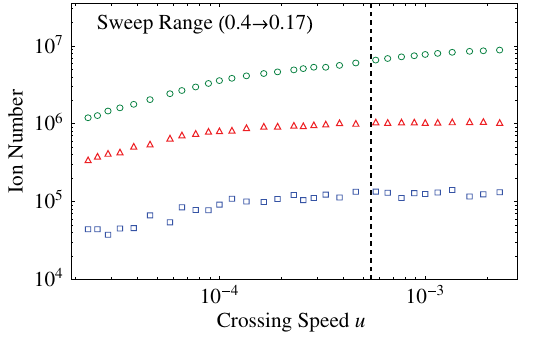
FIG. 10. Number of remaining ions after resonance crossing vs speed of bare-tune sweep. The bare tune per single rf period is changed from 0.4 to 0.17 at various ramping speeds of the rf quadrupole amplitude. The resonance crossing speed (abscissa) is defined as u ¼ (cid:7)=n rf where (cid:7) is the tune variation width (0.23 in all three cases) and n rf is the number of rf focusing periods spent for the tune sweep over (cid:7) . Three different initial plasma densities are considered; namely, N in (cid:3) 10 5 (blue square), 10 6 (red triangle), and 10 7 (green circle). For reference, the crossing speed corresponding to the 10-turn extraction from EMMA is indicated by a vertical broken line.